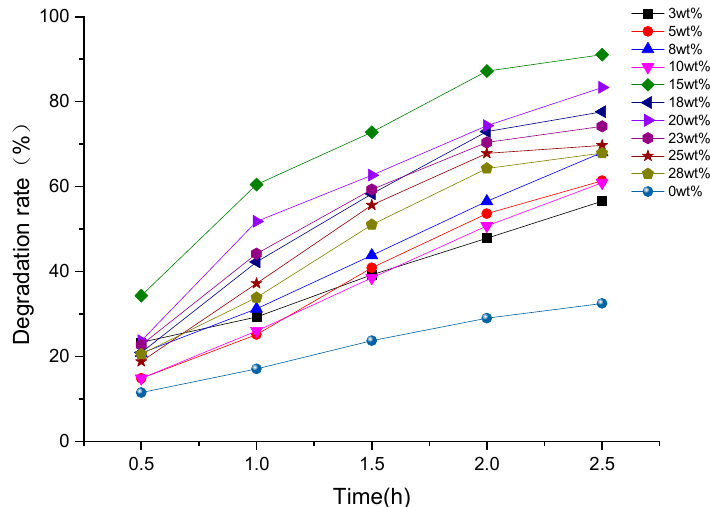
Figure 4. Degradation of methylene blue (MB) dye wastewater treated by photocatalyst containing different GO contents.